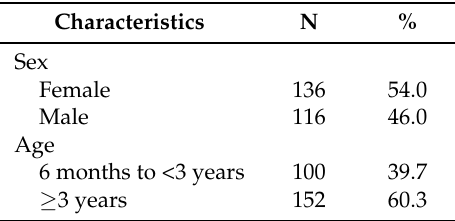
Table 2. Characteristics of study dogs eligible for analysis (N = 252).